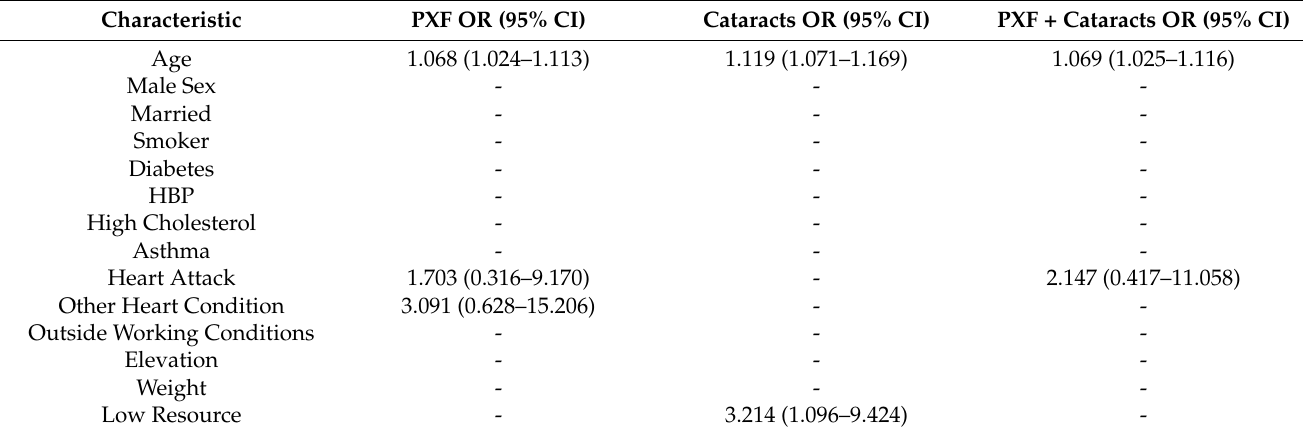
Table 5. Multivariate analysis of epidemiological risk factors and eye conditions.